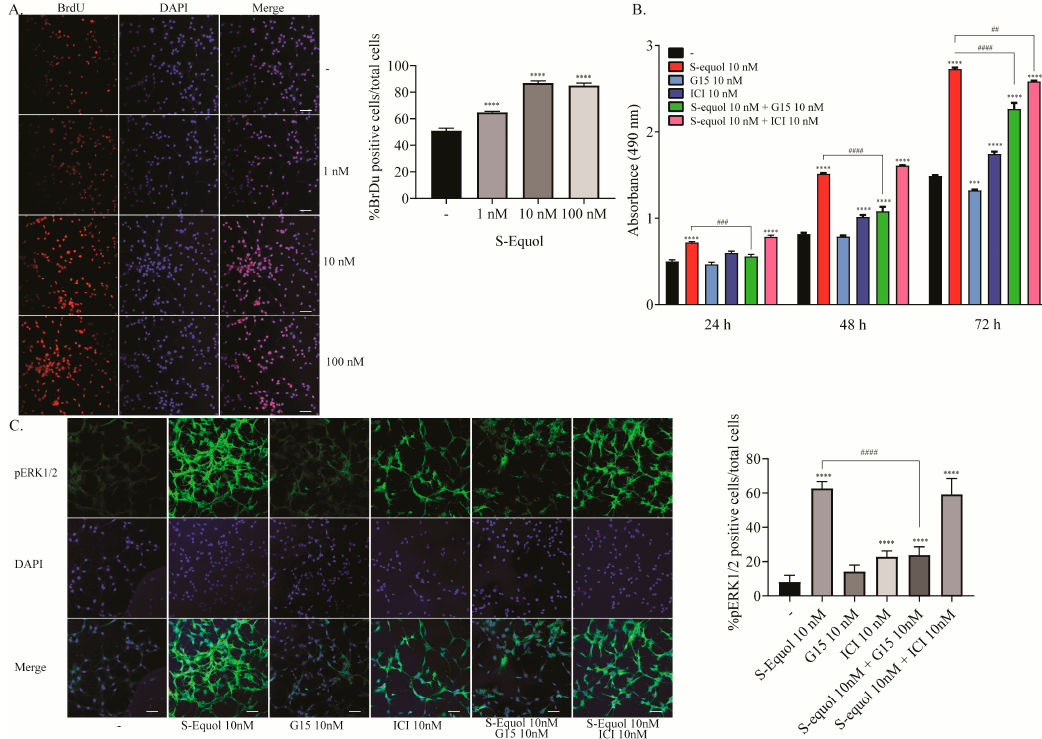
Figure 3. E ff ects of S-equol on mouse cerebellar astrocyte proliferation. Mouse primary cerebellar astrocytes were cultured for seven days followed by a BrdU incorporation assay, MTS cell proliferation assay, and immunohistochemical analysis with pERK1 / 2 and DAPI staining. ( A ) Representative photomicrographs showing the e ff ects of S-equol on the BrdU incorporation assay. The right panel shows the changes in the percentages of BrdU positive cells after exposure. ( B ) Time-dependent changes in the e ff ect of S-equol, G15, and / or ICI on cellular proliferation. Astrocytes were exposed to S-equol, G15, and / or ICI for 24, 48, and 96 h, respectively. Cell viability was determined with an MTS assay and the number of viable cells was calculated as a percentage of the control viability. ( C ) Representative photomicrographs showing the immunohistochemistry for pERK1 / 2 and DAPI staining to examine the e ff ect of S-equol, G15, and / or ICI on pERK1 / 2 expression. The right panel shows the changes in the percentages of pERK1 / 2 positive cells after exposure. The bars indicate 50 µ m. Data are expressed as the mean ± SEM ( n = 50 determinations) and are representative of at least three independent experiments. **** p < 0.0001, indicates statistical significance according to Bonferroni’s test compared with control (-). #### p < 0.0001, ### p < 0.001, and ## p < 0.005 indicate statistical significance according to Bonferroni’s test compared with S-equol.